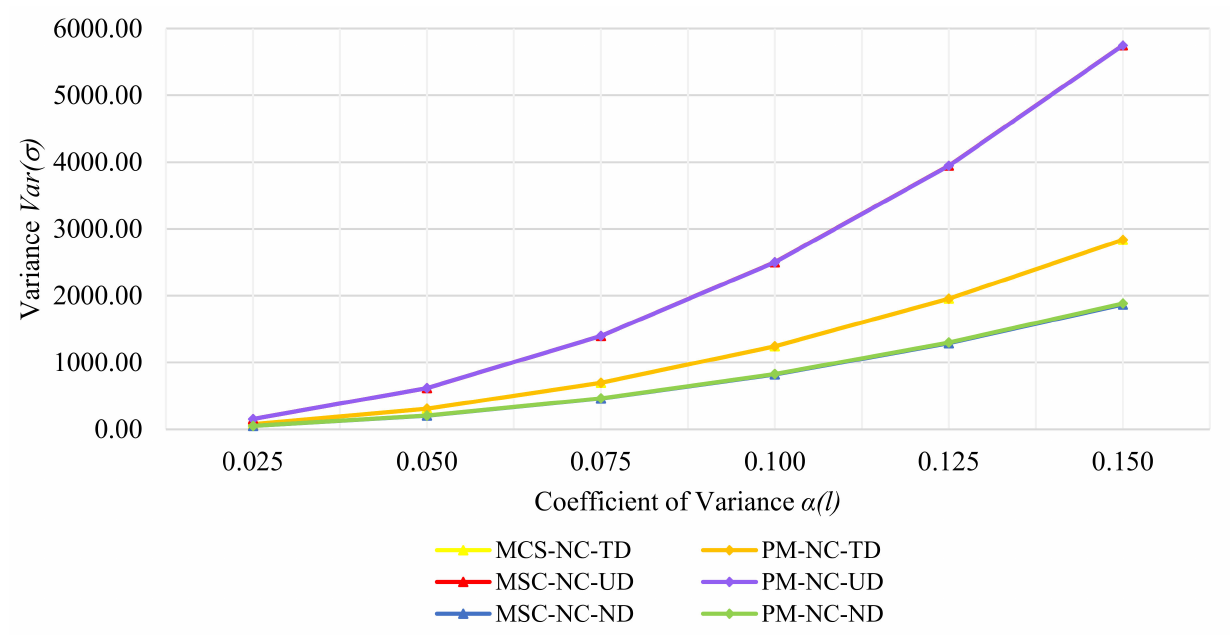
Figure 14. Variance Var in the